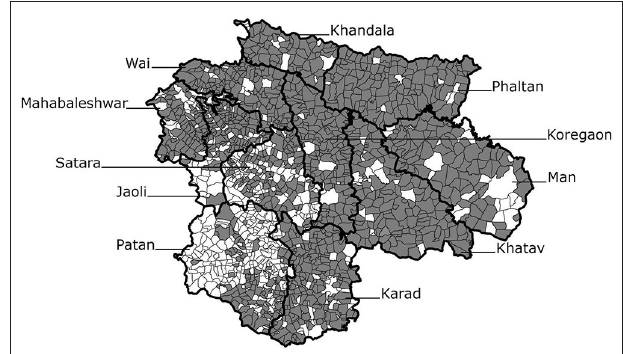
FIGURE 2 | Blocks and villages of Satara District (gray areas completed the survey) (Piyush Verma).